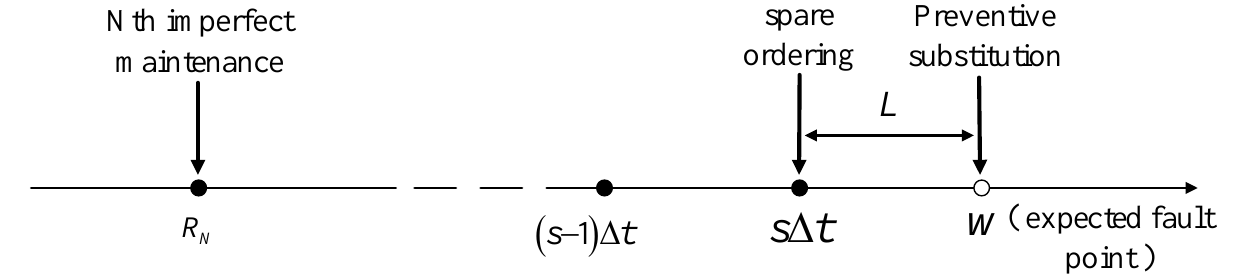
Figure 4. Preventive replacement and spare parts ordering process 2.